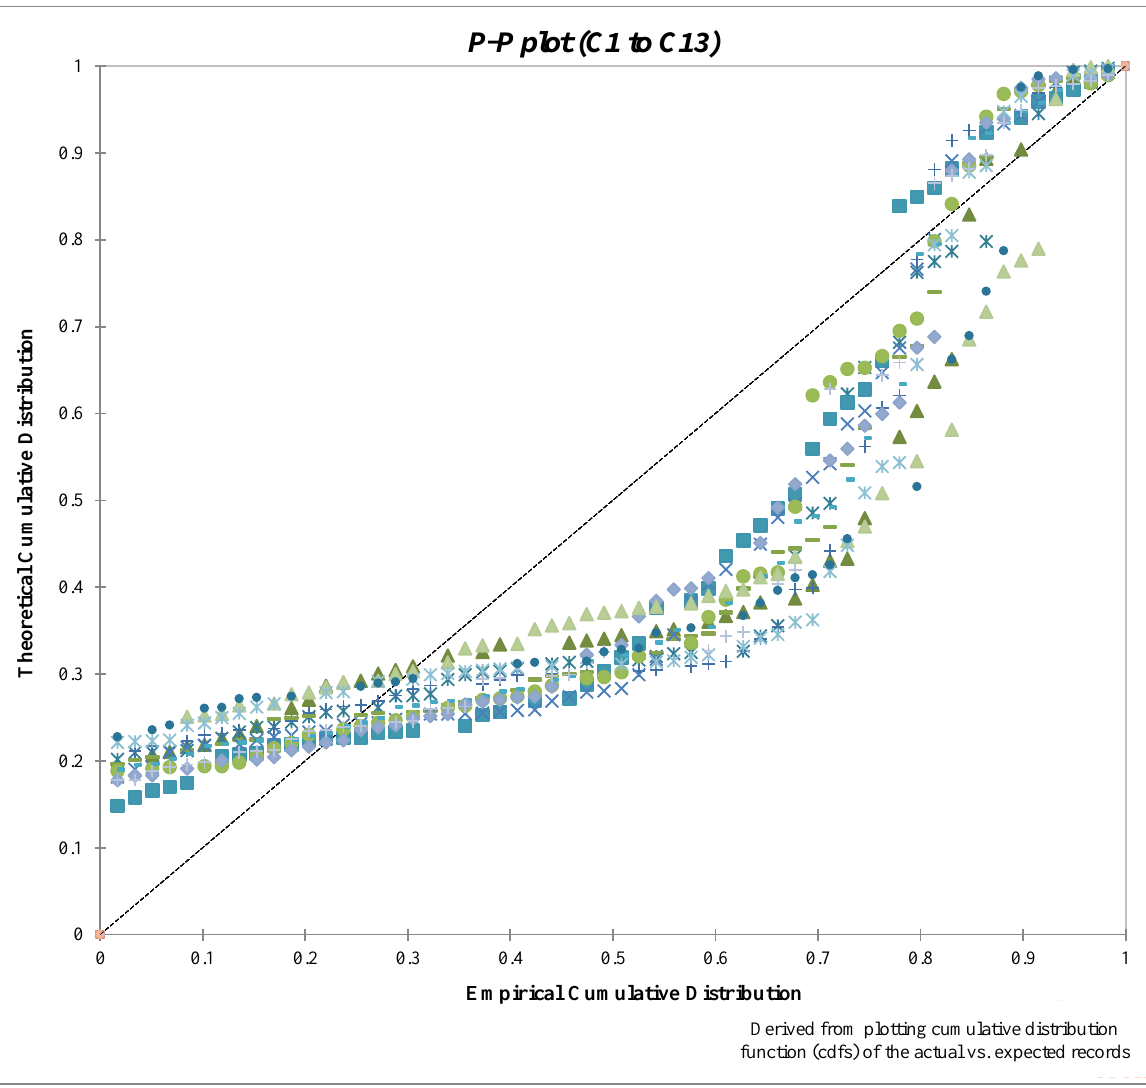
Empirical Cumulative Distribution Derived from plotting cumulative distribution function (cdfs) of the actual vs. expected Figure 3. Probability–Probability (P-P) plot of the actual versus the expected data dispersion of the point-of-use ports spreading across water distribution system in the plant